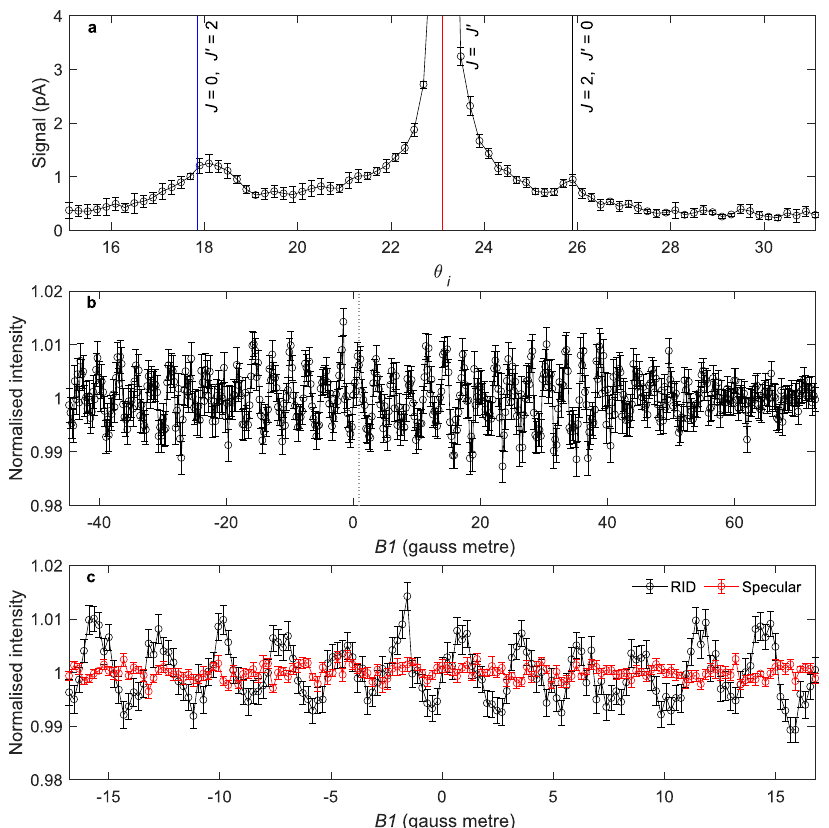
Fig. 2 Experimental data for D 2 scattering from Cu(111). a Incident angle scan, showing the positions of the specular scattering peaks for rotationally elastic scattering ( Δ J = 0, red) and rotationally inelastic scattering for J = 0 to J' = 2 (blue) and J = 2 to J' = 0 (black) transitions. b Normalised intensity of D 2 scattering from Cu(111) for the RID peak corresponding to the J = 2 to J' = 0 transition. The error bars represent standard errors from repeated B1 scans. c Comparison of the normalised intensity of D 2 scattering from Cu(111) for the RID peak (black) and the elastic specular peak (red). The error bars represent standard errors from repeated B1 scans. Source data are provided as a Source Data fi